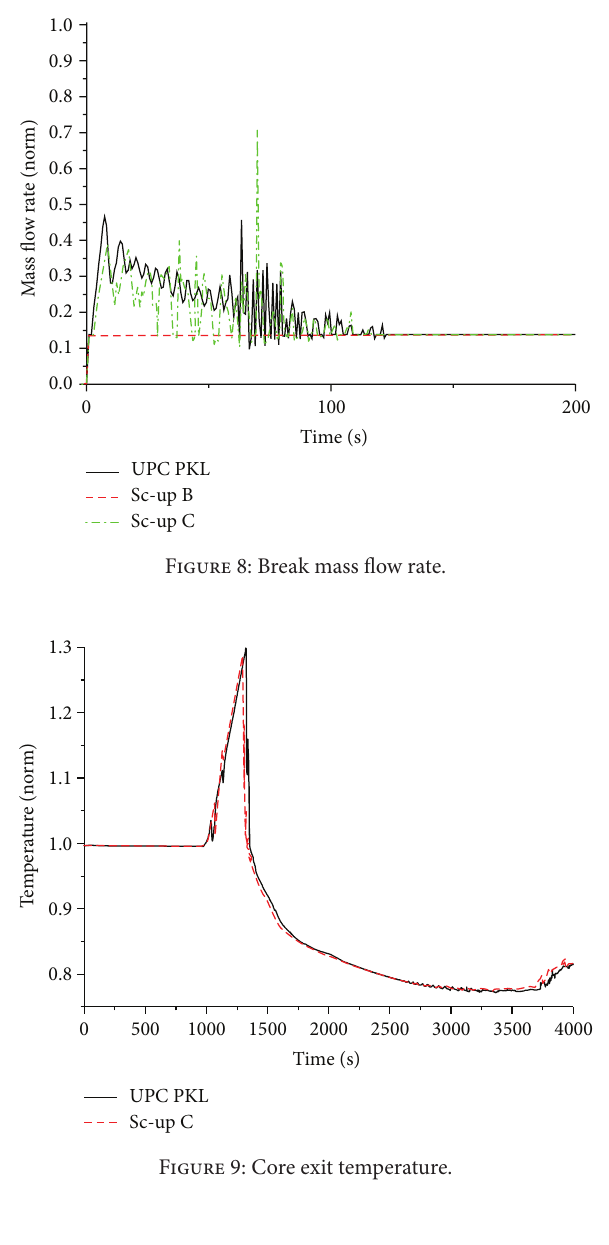
Figure 9: Core exit